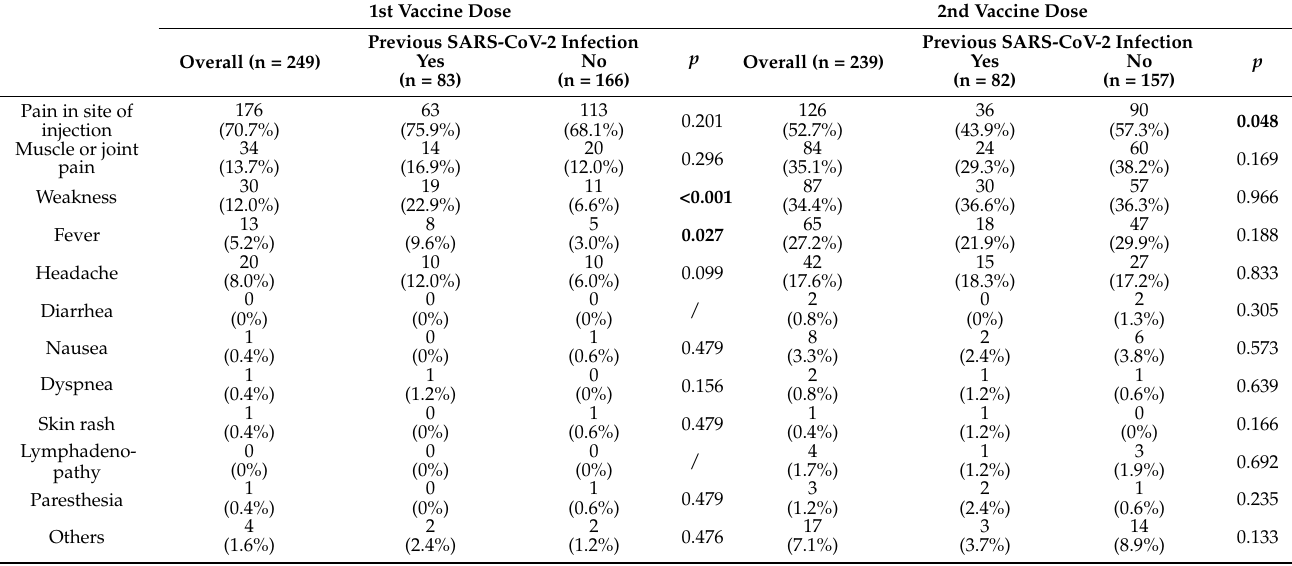
Table 3. Type of side effects after the first and second vaccine doses in the study population after case–control matching, overall and stratified according to prior SARS-CoV-2 infection. 1st Vaccine Dose 2nd Vaccine